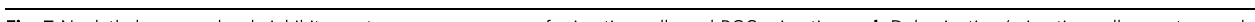
Fig. 7 Nonlethal caspase levels inhibit spontaneous emergence of migrating cells and PGC migration. a , b Delaminating/migrating cells spontaneously emerge in non-irradiated WDs (of the indicated genotypes) compromised for caspase activity. The pouch areas in the lower row (marked in green by the sal ::CPV) are the corresponding magni fi cations of the WD regions marked in yellow squares in the upper row. Arrows indicate delaminating/migrating cells detected by virtue of their compact shape (intense Venus fl uorescence; green) and MMP1 expression (red). The Z -axis projection in a corresponds to the dashed line region in the upper image. Scale bars, upper row 50 µ m and lower row 20 µ m. c Quanti fi cations of the intense Venus and MMP1 double-positive cells in a . “ Pouch ” and “ Notum ” indicate the WD areas in which the cells were detected. The examined WD numbers ( N ) are indicated for each graph bar. Error bars indicate s.e.m. *** P < 0.001, two-tailed unpaired Student ’ s t test. d Some of the intense Venus and MMP1 double-positive cells in the non- irradiated dcp-1 − / − ; drice − / − double mutant WDs migrated away from the pouch (arrows; quanti fi ed in c ). Scale bar, 20 µ m. e The developmental migration of PGCs is affected by low increase in effector caspase levels. Stage 13 embryos overexpressing the full length dcp-1 and drice coding regions (zymogens) in PGCs using the nos -Gal4 driver (which drives both maternal and zygotic expressions). PGCs are marked by anti-Vasa antibody staining. Yellow arrowheads indicate PGCs that correctly migrated to the gonads. White arrows and asterisks indicate PGCs that failed to migrate properly in the fi rst and second migration phases, respectively. f Quanti fi cation of the percentage of stage 13 embryos with migration defects in genotypes shown in e . The numbers of examined embryos ( N ) are indicated. Scale bar, 50 μ m. g A model of irradiation-induced cell migration and apoptosis in the WD epithelial tissue. The green area (pouch) indicates a subdomain that is severely compromised for effector caspase activity, whereas the gray areas indicate WT